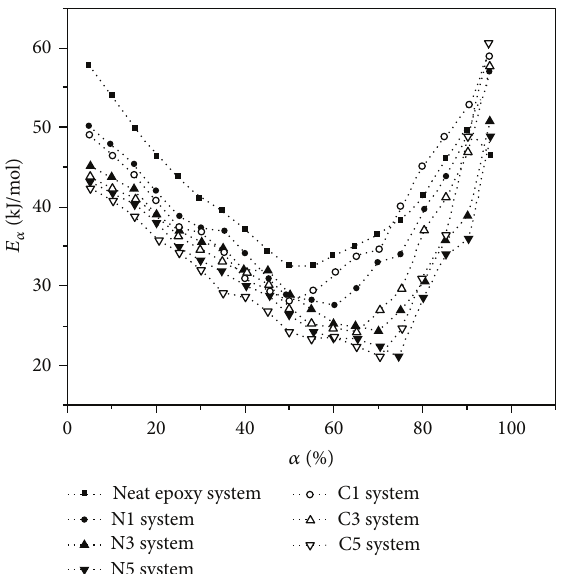
Figure 4: Plots of activation energy against 𝛼 of neat epoxy, untreated systems containing 1, 3, and 5 wt% of MWCNTs (N1, N3, N5), and functionalized systems containing 1, 3, and 5 wt% of COOH-MWCNTs (C1, C3, C5). Dotted lines are given for showing the tendency. After [21].